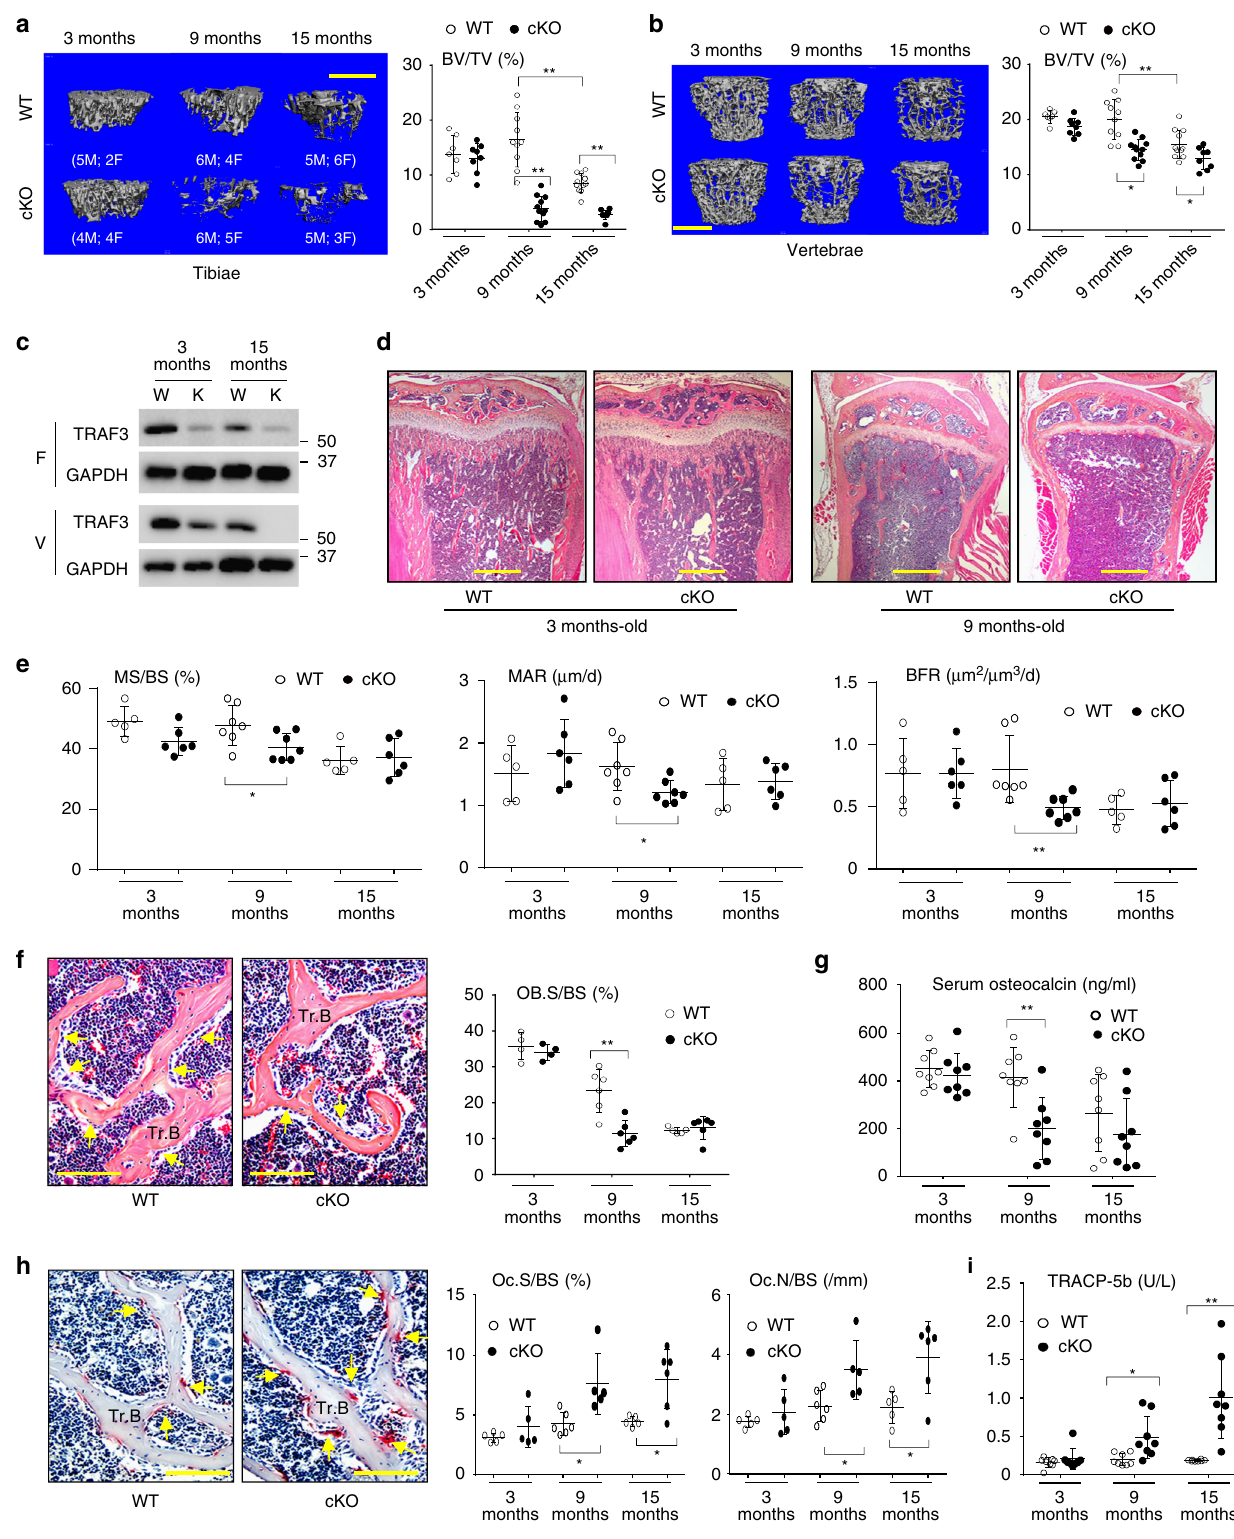
signi fi cant differences in osteoclast numbers and surfaces in the vertebral sections or in serum TRACP5b levels among 3-, 9-, and 15- month-old WT mice (Fig. 1h, i). This may re fl ect the fact that 15-month-old WT mice are still not aged and are equivalent to ~50-year-old humans 27 who still tend to have normal bone turnover marker levels 28